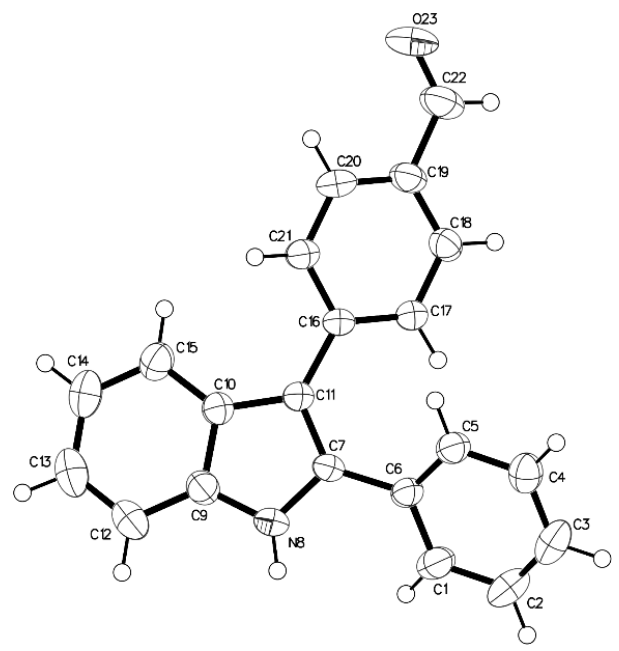
Figure 1. The ORTEP drawing of the 2-phenyl-3-(4-formylphenyl)indole ( 2 ) with thermal ellipsoids at 30% level. Table 1. In vitro sensitivity of Plasmodium falciparum , Leishmania donovani and Trypanosoma brucei brucei strains to compound 4 and cytotoxicity of these compounds in HepG2 cells.